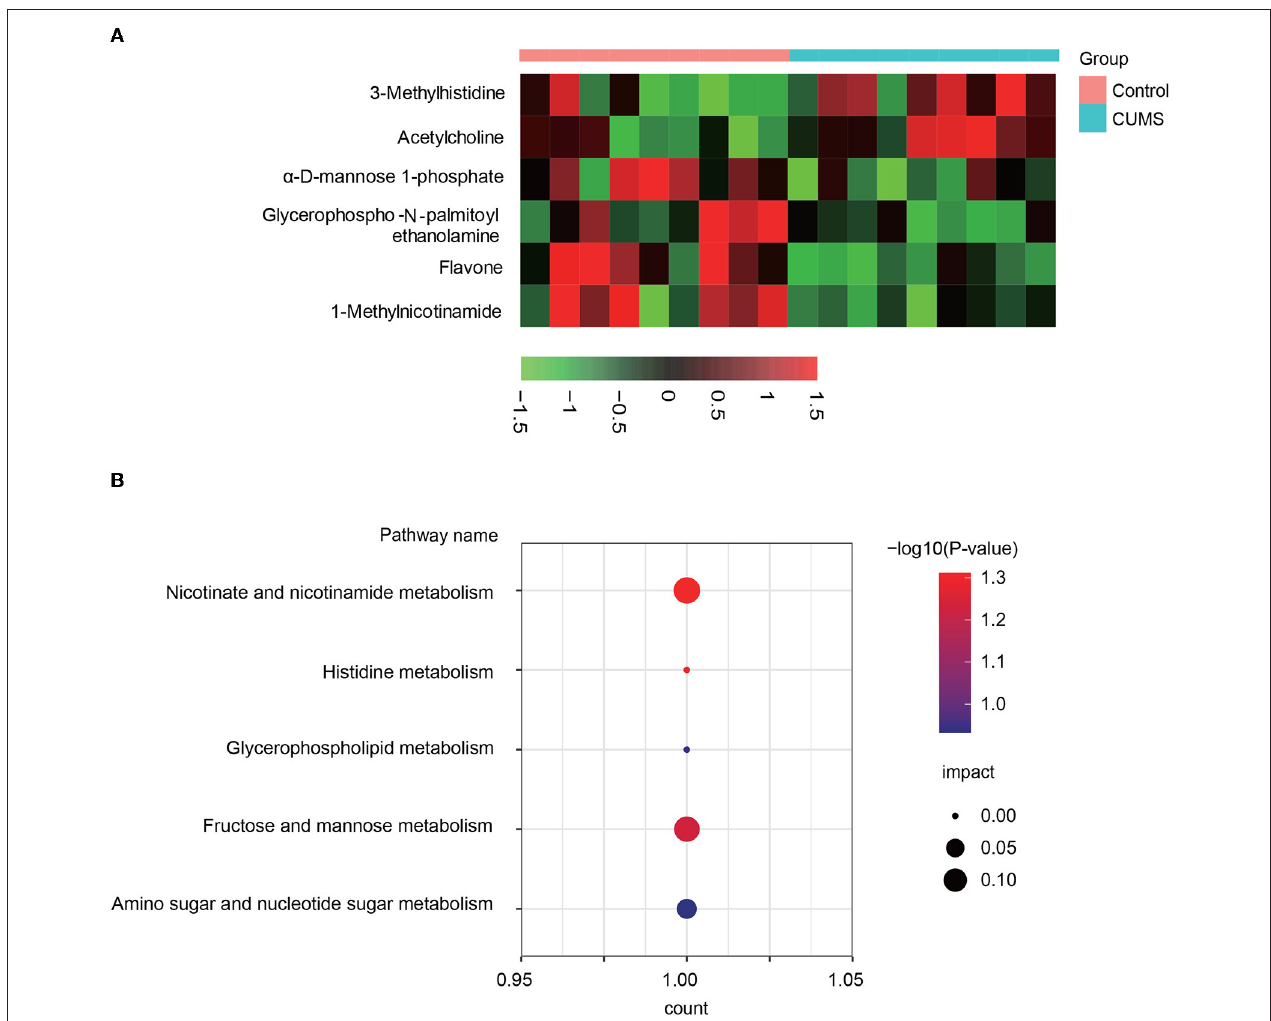
FIGURE 4 | Bioinformatic analysis of significantly differentially expressed metabolites. (A) Red indicates significantly up-regulated metabolites, whereas black indicates significantly down-regulated metabolites in the PFC. (B) Bubble chart of the metabolic pathway analysis. The p -value and impact factor are represented by dot color and dot size, respectively. The count represents total number of hits in the metabolic